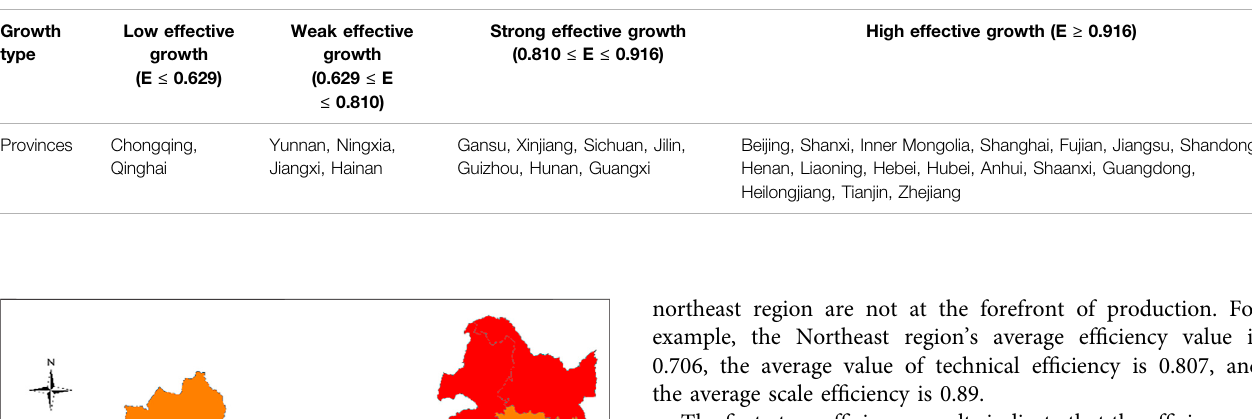
TABLE 4 | The growth model of GTFP ef fi ciency.